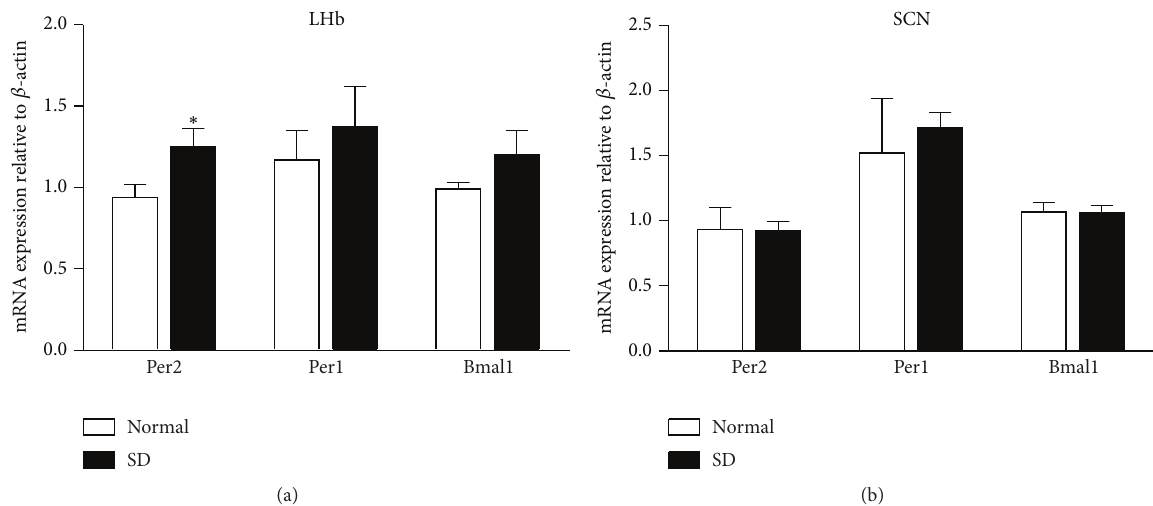
Figure 3: Sleep deprivation alters mRNA levels of clock genes. qPCR analysis of the expression of three clock genes (Per1, Per2, and Bmal1) in the LHb (a) and SCN (b) of the rat. Data was presented as mean ± SEM ( 𝑛 = 8 /each group). ∗ 𝑃 < 0.05 , compared with control group (by unpaired 𝑡 -test).